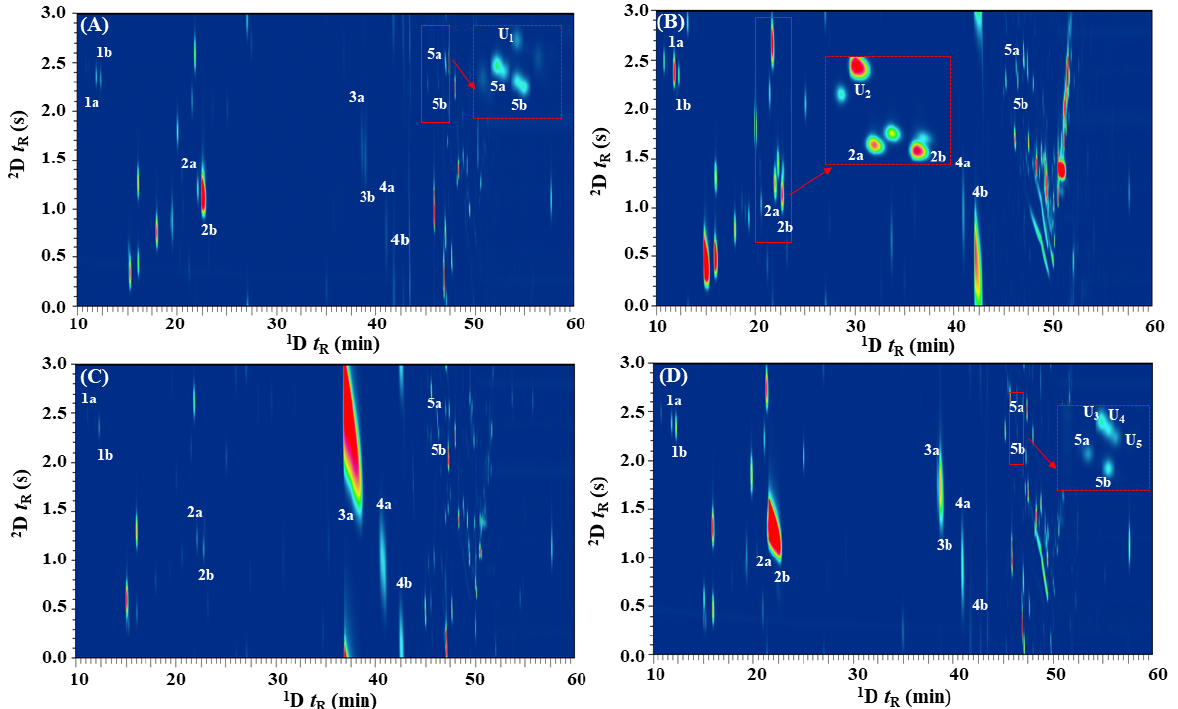
Figure 3. The enantioanalysis of chiral monoterpenes in Citrus spp. leaf EOs using e GC×GC–FID. ( A ) C. limon ; ( B ) C. microcarpa ; ( C ) C. hystrix ; and ( D ) C. pyriformis . 1a, ( − ) ‐α‐ pinene; 1b, (+) ‐α‐ pinene; 2a, ( − ) ‐ limonene; 2b, (+) ‐ limonene; 3a, ( − ) ‐ citronellal; 3b, (+) ‐ citronellal; 4a, ( − ) ‐ linalool; 4b, (+) ‐ linalool; 5a, (+) ‐ terpinen ‐ 4 ‐ ol; and (5b), ( − ) ‐ terpinen ‐ 4 ‐ ol.